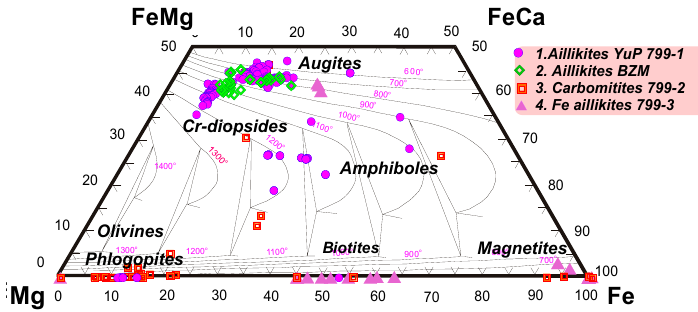
Figure 13. Pyroxene quadrilateral for aillikite minerals [63] of BZM, YuP and aillikites and carbonatite dykes located in Belaya Zima river basin. The compositions of olivines, amphiboles, phlogopites and magnetites are projected and do not corresponds the isotherms.